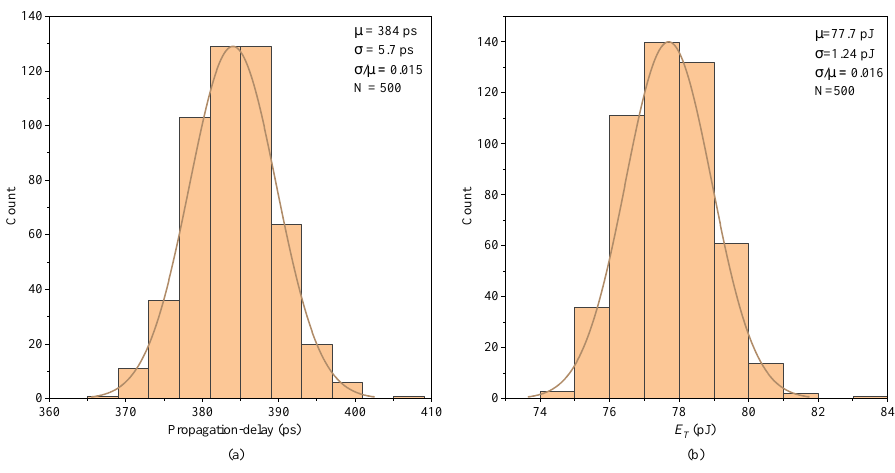
Figure 13. Monte Carlo simulation: ( a ) Average propagation delay, ( b ) E T .